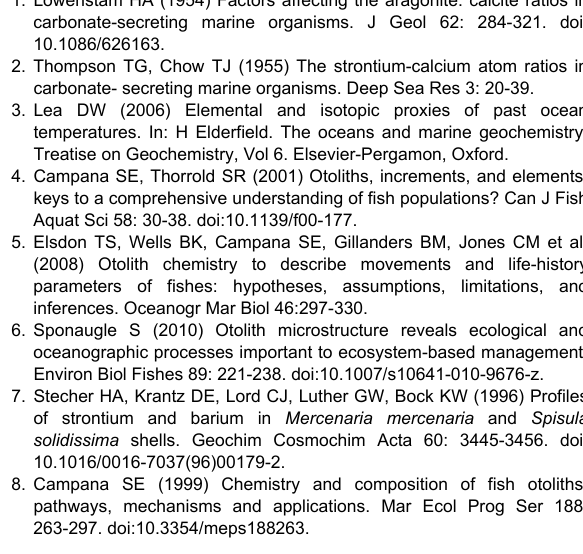
Table S2. Correlations (r) between partition coefficients (D ) and somatic growth rates and vertebral Me